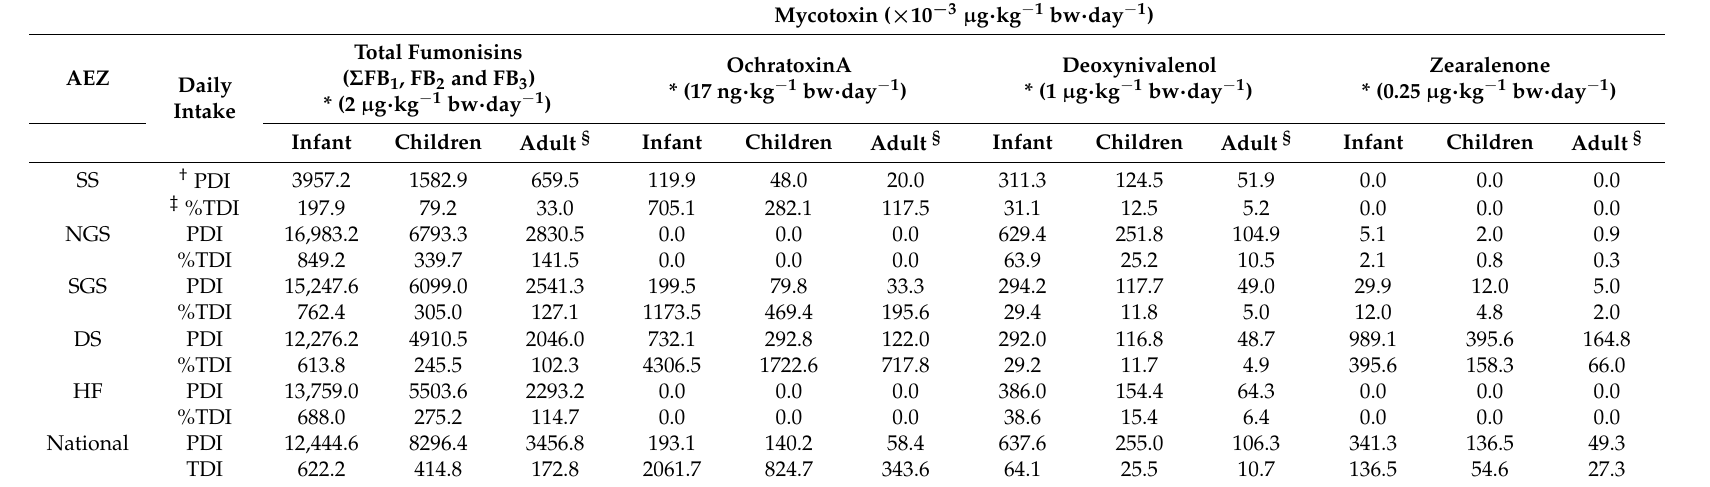
Table 2. Risk characterization of non-genotoxic and non-carcinogenic mycotoxins based on probable daily